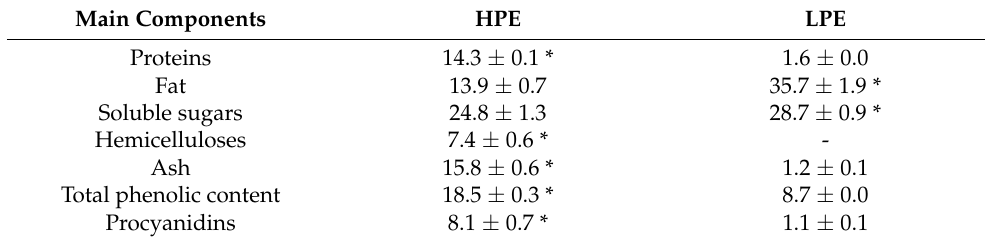
Table 1. Composition of PLE grape stem extracts (% w/w ).